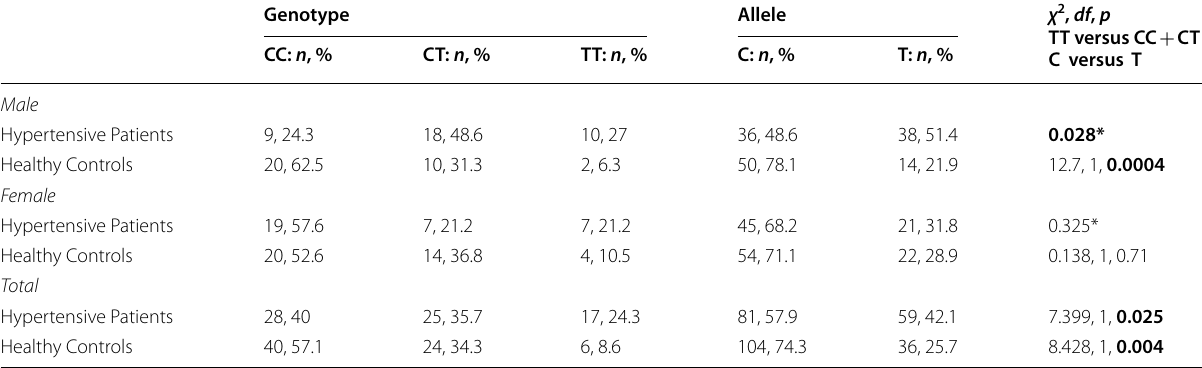
Statistically significant p values (> 0.05) were presented in bold for them to be distinguishable from the non-significant